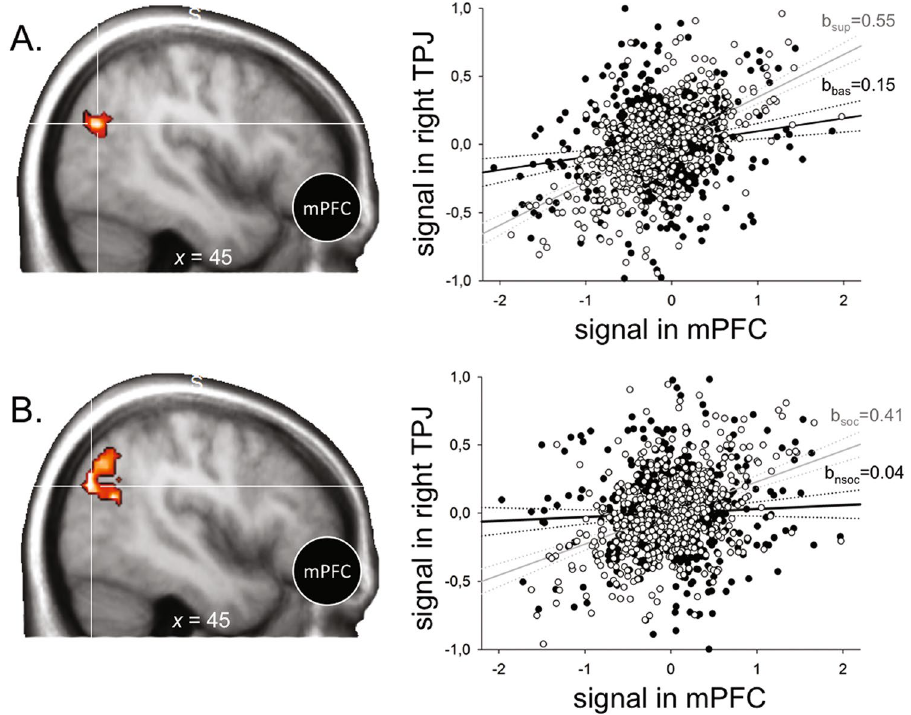
Figure 5. Analyses of functional connectivity between mPFC and TPJ in both experiments. ( A ) PPI of mPFC and right TPJ for a single subject in Experiment 1: Non-Social Superordinate intentions, relative to Non-Social Basic intentions, led to significantly increased connectivity between both regions. Measurements during inference of Non-Social Superordinate intentions: white circles; measurements during inference of Non-Social Basic intentions: black circles. Mean-corrected activity in right TPJ is displayed as a function of mean-corrected activity in mPFC. Condition-specific regression slopes, b sup (Superordinate) and b bas (Basic). ( B ) PPI of mPFC and right mPFC for a single subject in Experiment 2: Social Basic intentions, relative to Non-Social Basic intentions, led to significantly increased connectivity between both regions. Measurements during inference of Social Basic intentions: white circles; measurements during inference of Non-Social Basic intentions: black circles. Mean-corrected activity in right TPJ is displayed as a function of mean-corrected activity in mPFC. Condition-specific regression slopes, b soc (Social) and b nsoc (Non-Social). In A and B, the difference between regression slopes constitutes the PPI (all P’s < 0.001, all T’s =